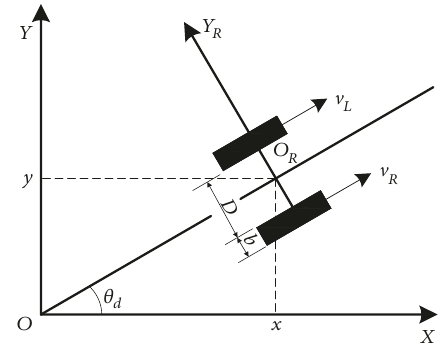
Figure 1: Kinematics analysis diagram of double